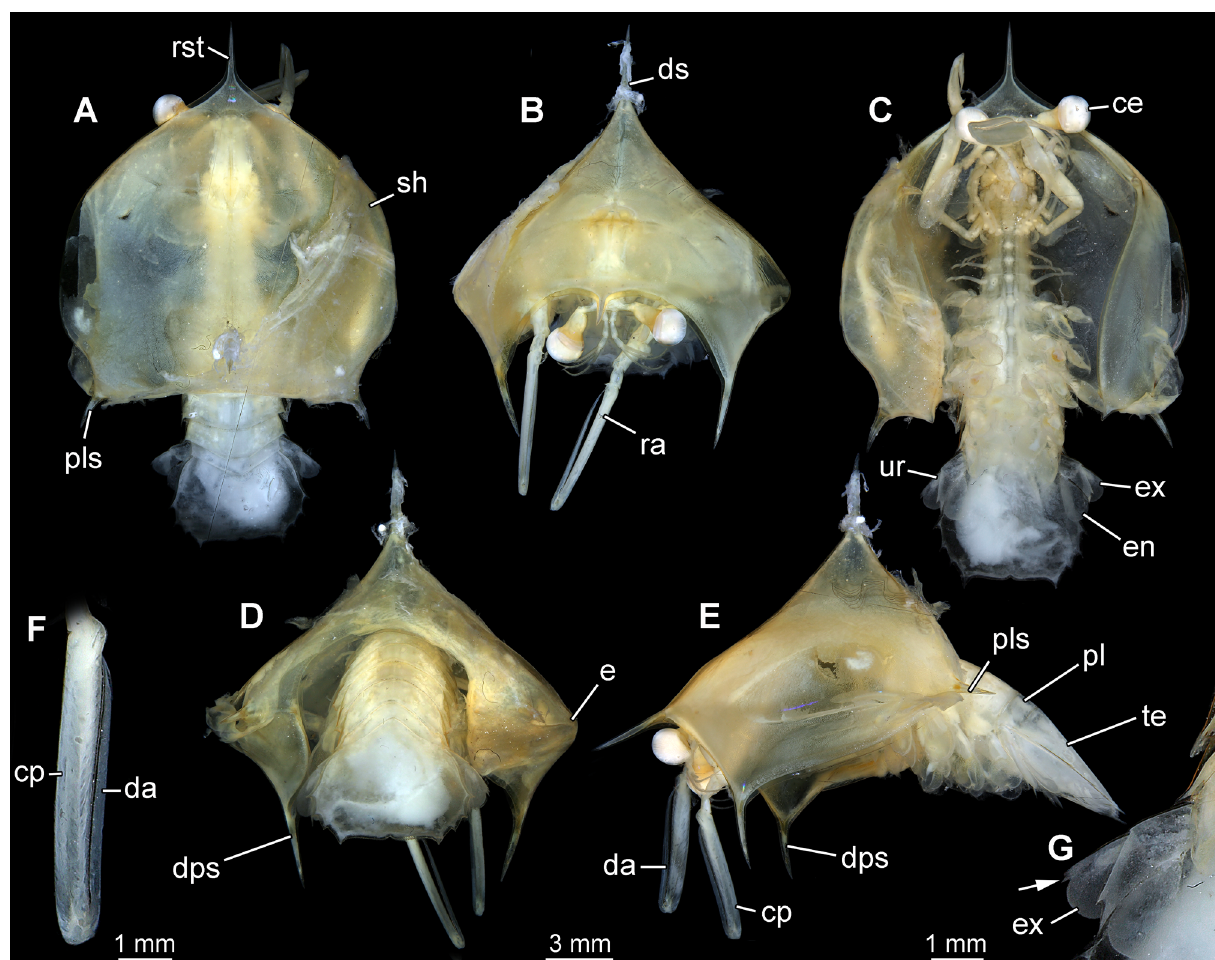
Figure 2. New morphotype 5, “spiked helmet”, specimen 30023A. A. Dorsal view. B. Anterior view. C. Ventral view. D. Posterior view. E. Lateral view on left side. F. Close-up of raptorial appendage. G. Close-up of uropod; note single tooth-like spine on the exopod (arrow). Abbreviations: ce = compound eye; cp = carpopropodus; da = dactylus; dps = downward pointing spine; ds = dorsal spine; e = edge; en = endopod; ex = exopod; pl = pleon; pls = postero-lateral spine; ra = raptorial appendage (appendage